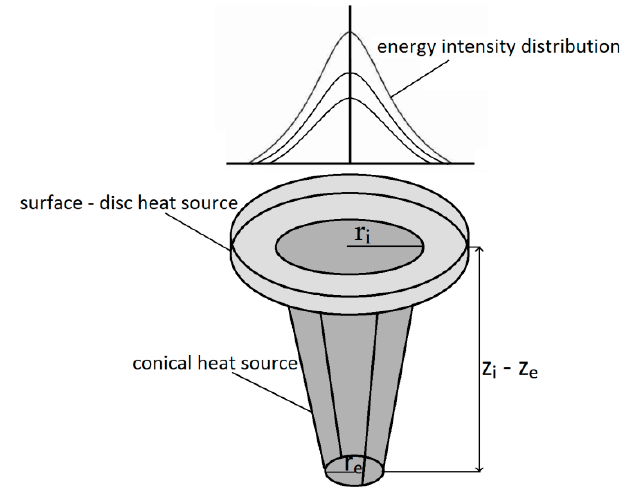
Figure 1. Heat-source model used in laser-welding simulation.